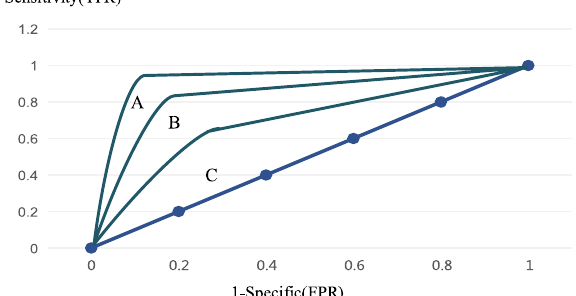
Fig. 8 Comparison of different ROC-AUC